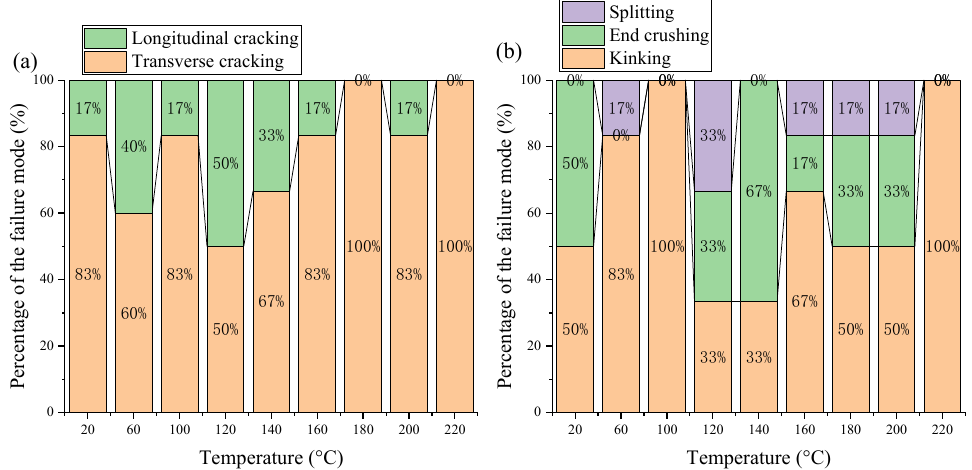
Figure 5. Percentages of the failure modes of the specimens under (a) tension and (b) compression.